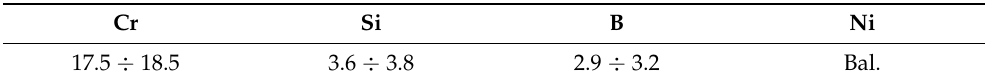
Table 1. Nominal composition of experimental NiCrBSi powder used as the metal matrix (wt.%), Figures 2 and